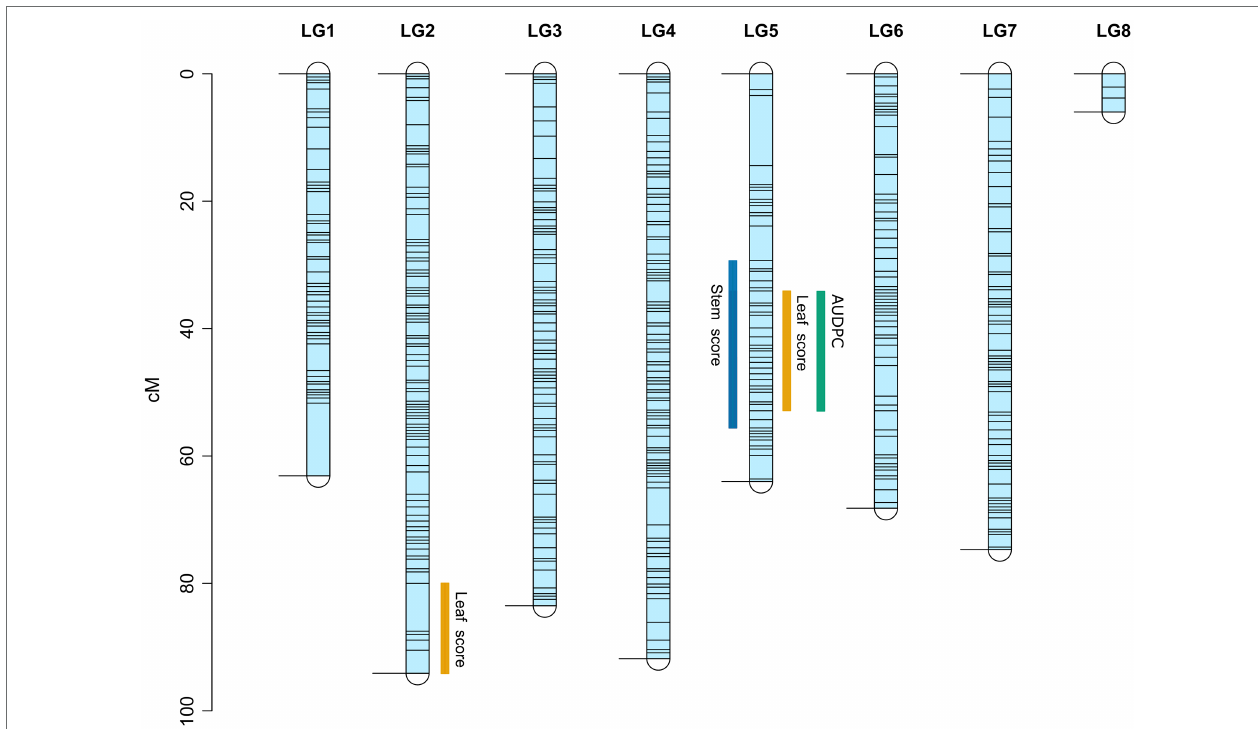
FIGURE 4 | Linkage map of the interspecific RIL population derived from a cross between ILWL 180 and ILL 6002. Black horizontal lines represent the position of genetic markers. Regions of identified QTL for Ascochyta blight disease symptoms are marked with blue, orange and green bars for stem lesions, leaf lesions and AUDPC,